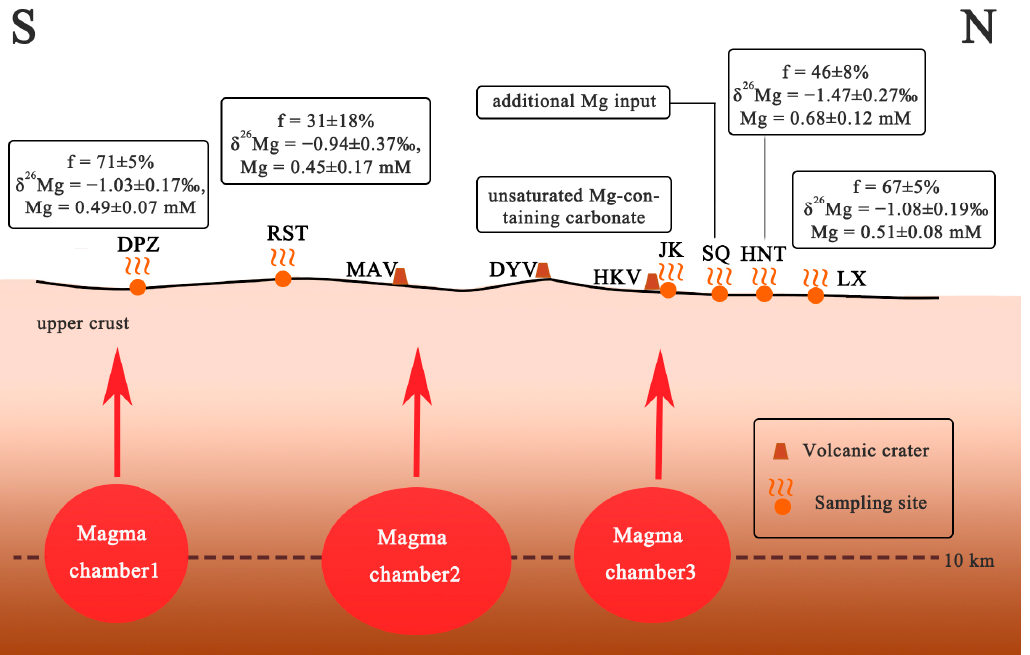
Figure 8. The removal rate of Mg and δ 26 Mg values of Tengchong hydrothermal endmember fluid (before Mg − containing carbonate precipitation).